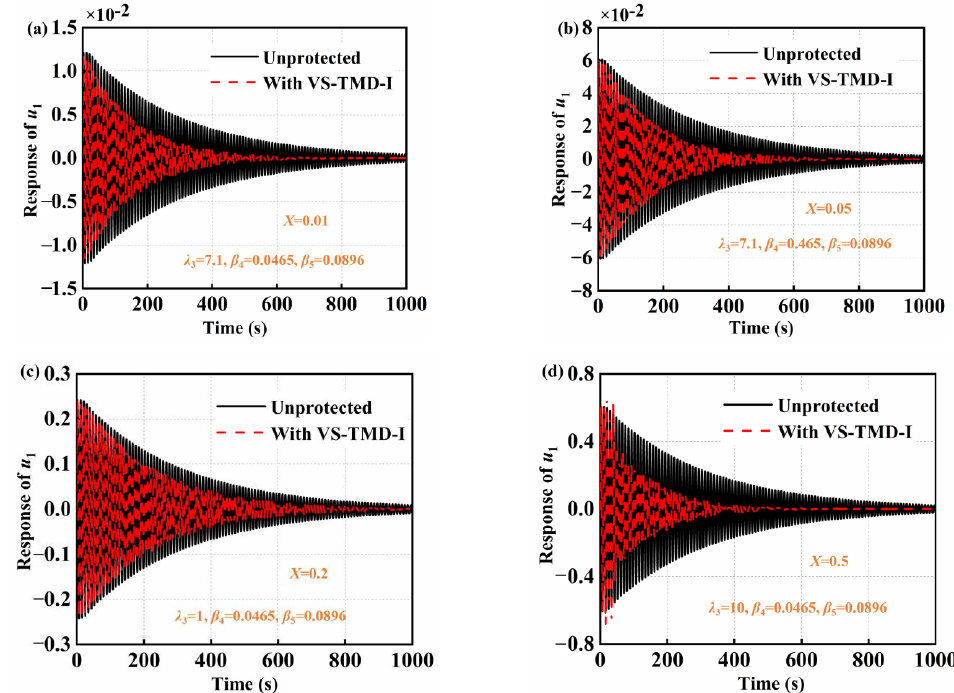
Figure 11. The transient responses of u 1 with various initial impulses: ( a ) X = 0.01; ( b ) X = 0.05; ( c ) X = 0.2; ( d ) X = 0.5.